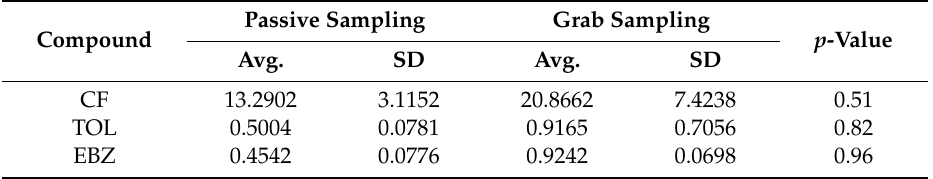
Table 6. Comparison of the grab sampling and passive sampling methods for 2 days of collection. The p -values are from a t -test at α = 0.05.